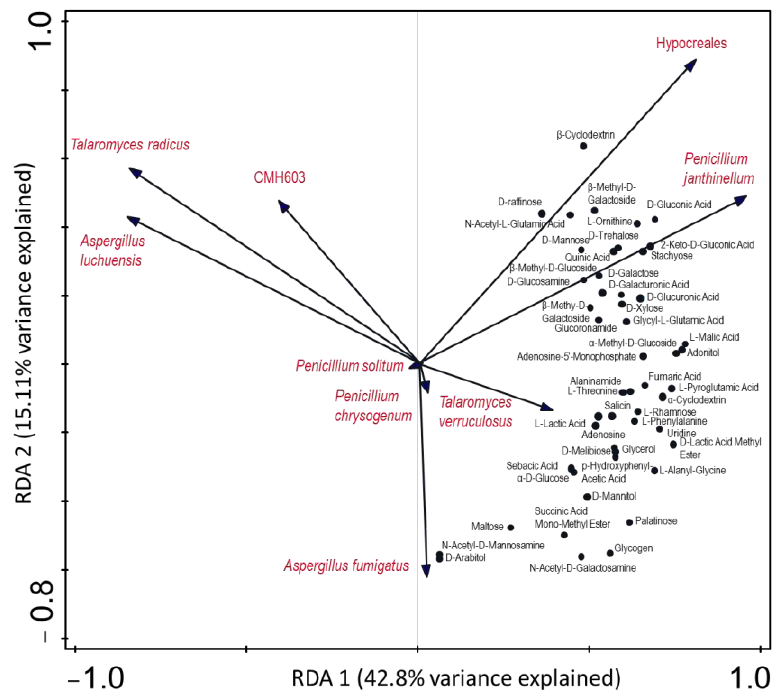
Figure 6. Redundancy Analysis biplot of carbon utilization by Trichocomaceae species constrained by genus. Points represent 50 best-fitting (out of 95) carbon substrates shown using data compiled from 40 isolates from the results of the Filamentous Fungal identification plates. Response values are transformed as log ( x + 0.01) and carbons were centered and standardized. An uncultured Hypocreaceae is included as a reference outlier. Eigenvalues are 0.2458, 0.0921, 0.0731, and 0.0405 for the x -, y -, third, and fourth axes, respectively (pseudo- F = 2.2, p = 0.004). Analysis performed with Canoco Ver 5 software.